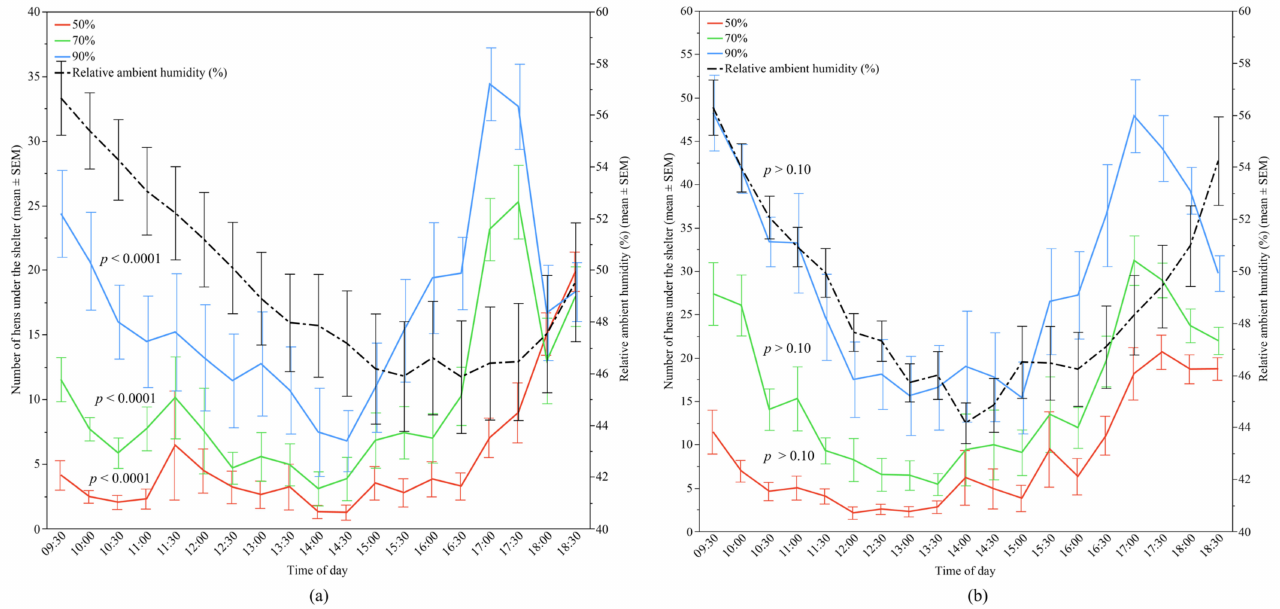
Figure 7. The mean ( ± SEM) number of hens under the different UV-filtering shelters (50%, 70%, and 90%) and the mean ( ± SEM) relative ambient humidity throughout the day: ( a ) Flock-A; ( b ) Flock-B ( p > 0.10 indicates the variable had no significant effect and was removed from final model). Note the different Y-axis scales between Flock-A and Flock-B. Raw values are presented with analyses conducted on transformed